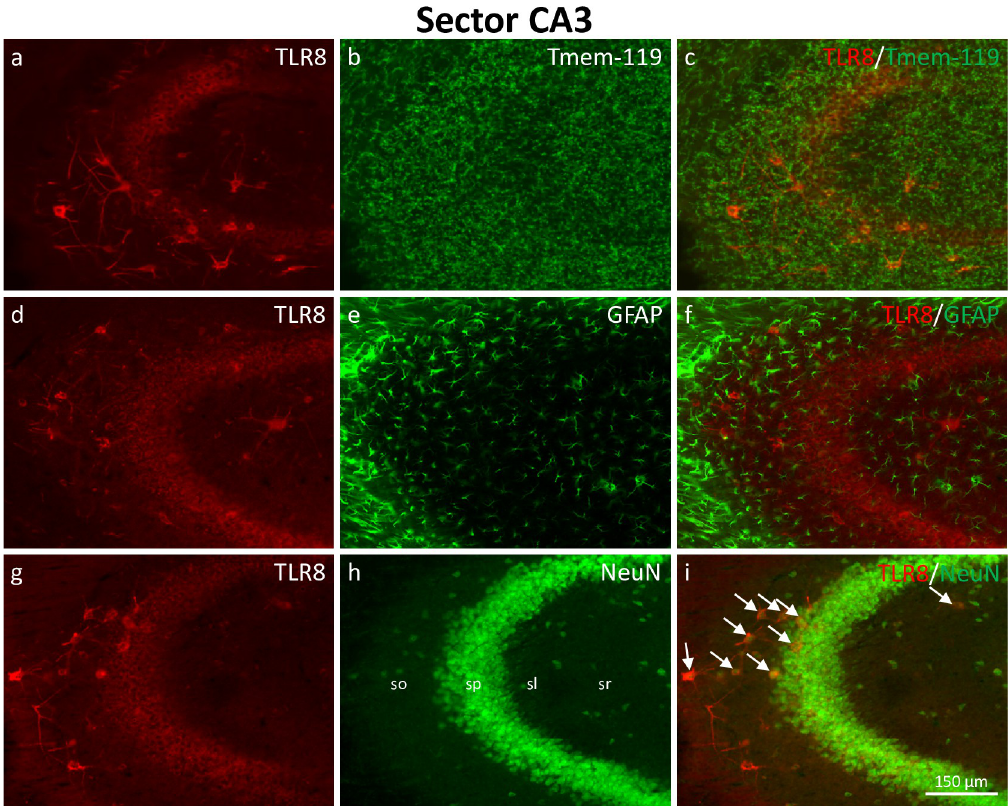
Fig 3. Expression of TLR8 in hippocampal sector CA3. Double-immunofluorescence showing TLR8 together with the glial markers Tmem-119 (microglia, a-c) and GFAP (astrocytes, d-f) and with the neuronal marker NeuN (g-i). In sector CA3 of the hippocampus proper, GABAergic interneurons strongly expressing TLR8 were located in stratum oriens, stratum pyramidale, stratum lucidum, and stratum radiatum (a, d, g). Weak expression of TLR8 was also present in glutamatergic pyramidal cells in stratum pyramidale. Also, in sector CA3, expression of TLR8 was restricted to neurons (see arrows in i); microglia and astrocytes did not express TLR8. Abbreviations: so, stratum oriens; sp, stratum pyramidale; sl, stratum lucidum; sr, stratum